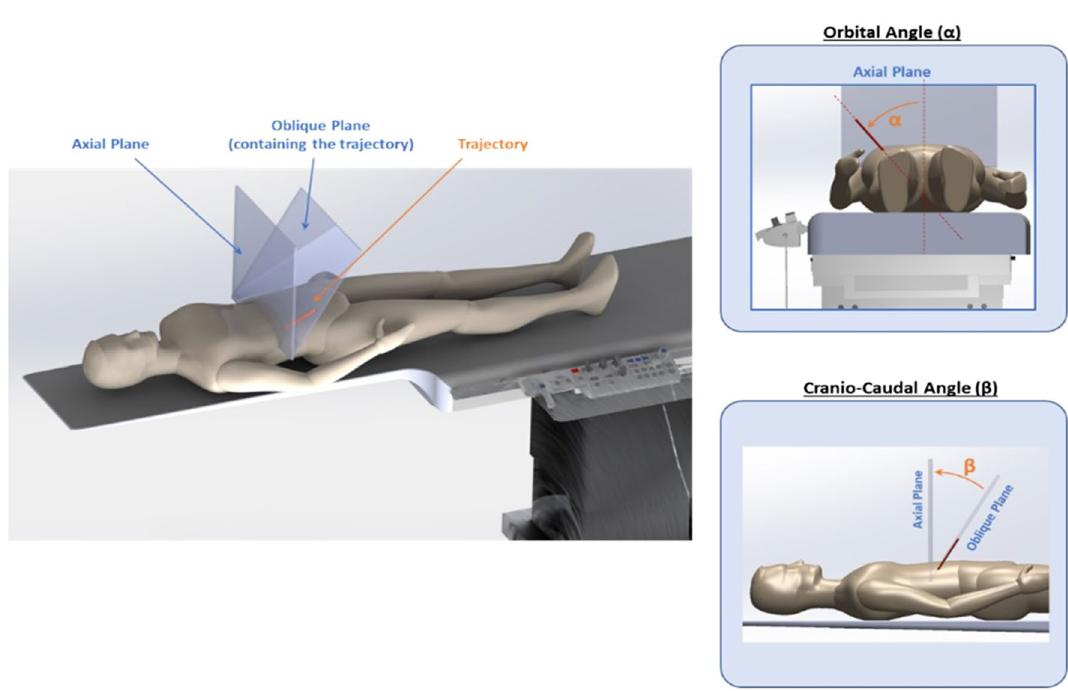
Figure 6. Axial and coronal maximum intensity projection CT images showing the placement of fiducials in a swine